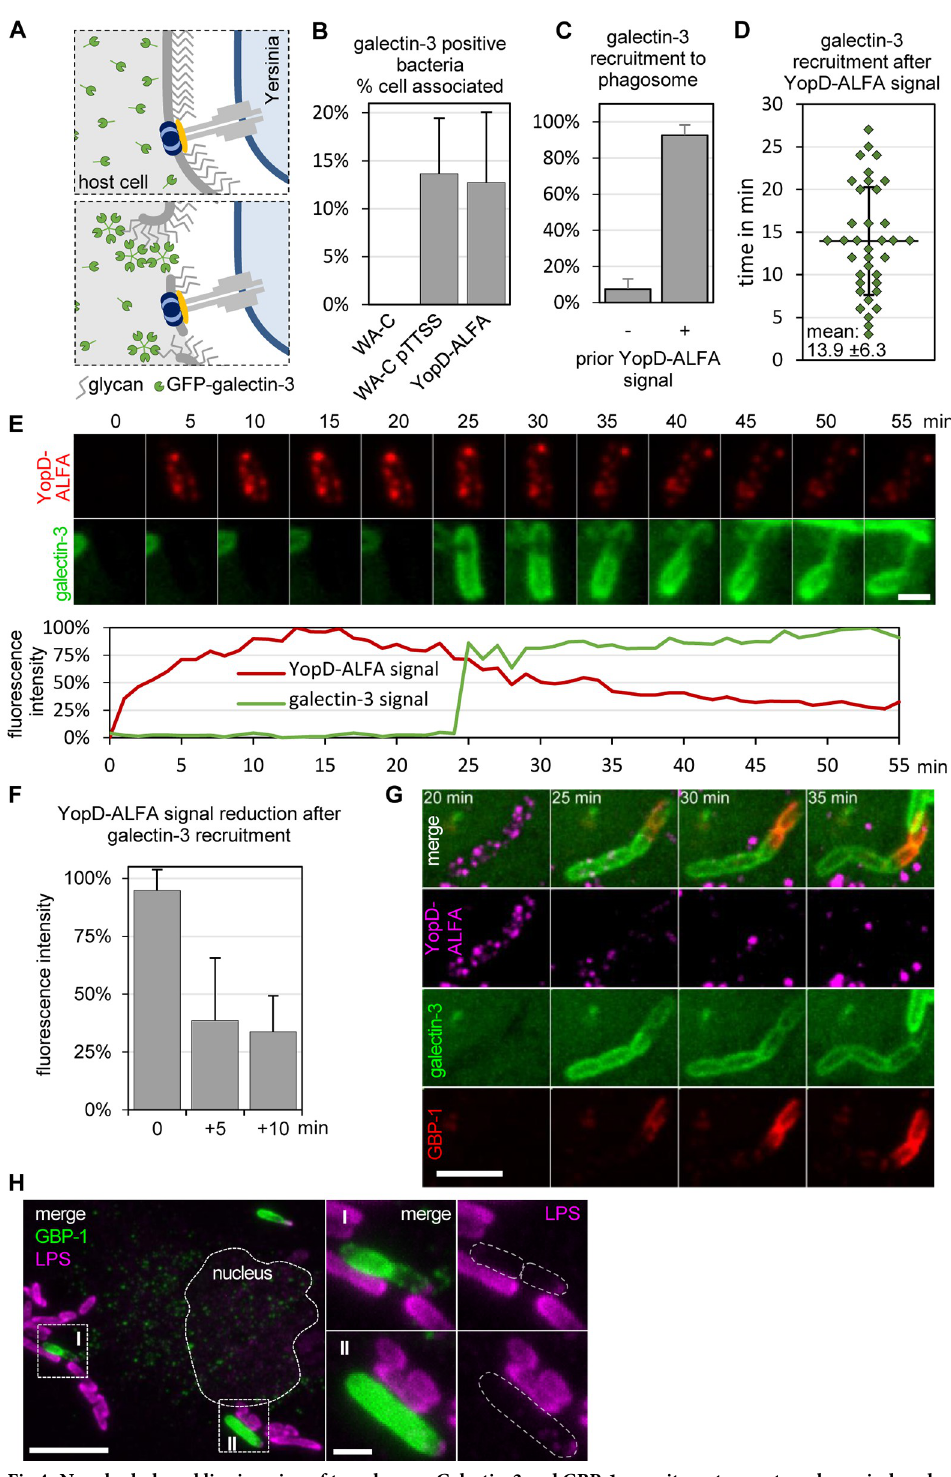
Fig 4. Nanobody-based live imaging of translocons: Galectin-3 and GBP-1 recruitment upon translocon induced membrane damage. (A) Schematic representation of galectin-3 recruitment following membrane damage during infection. Galectin-3 (shown in green) is found in the cytosol of the host cell. Translocon formation appears to induce membrane damage allowing access of galectin-3 to glycans in the lumen of vacuoles. (B) Vacuolar membrane damage by the T3SS. HeLa cells expressing myc-Rac1Q61L and GFP-galectin-3 were infected with WA-C, WA-C pTTSS